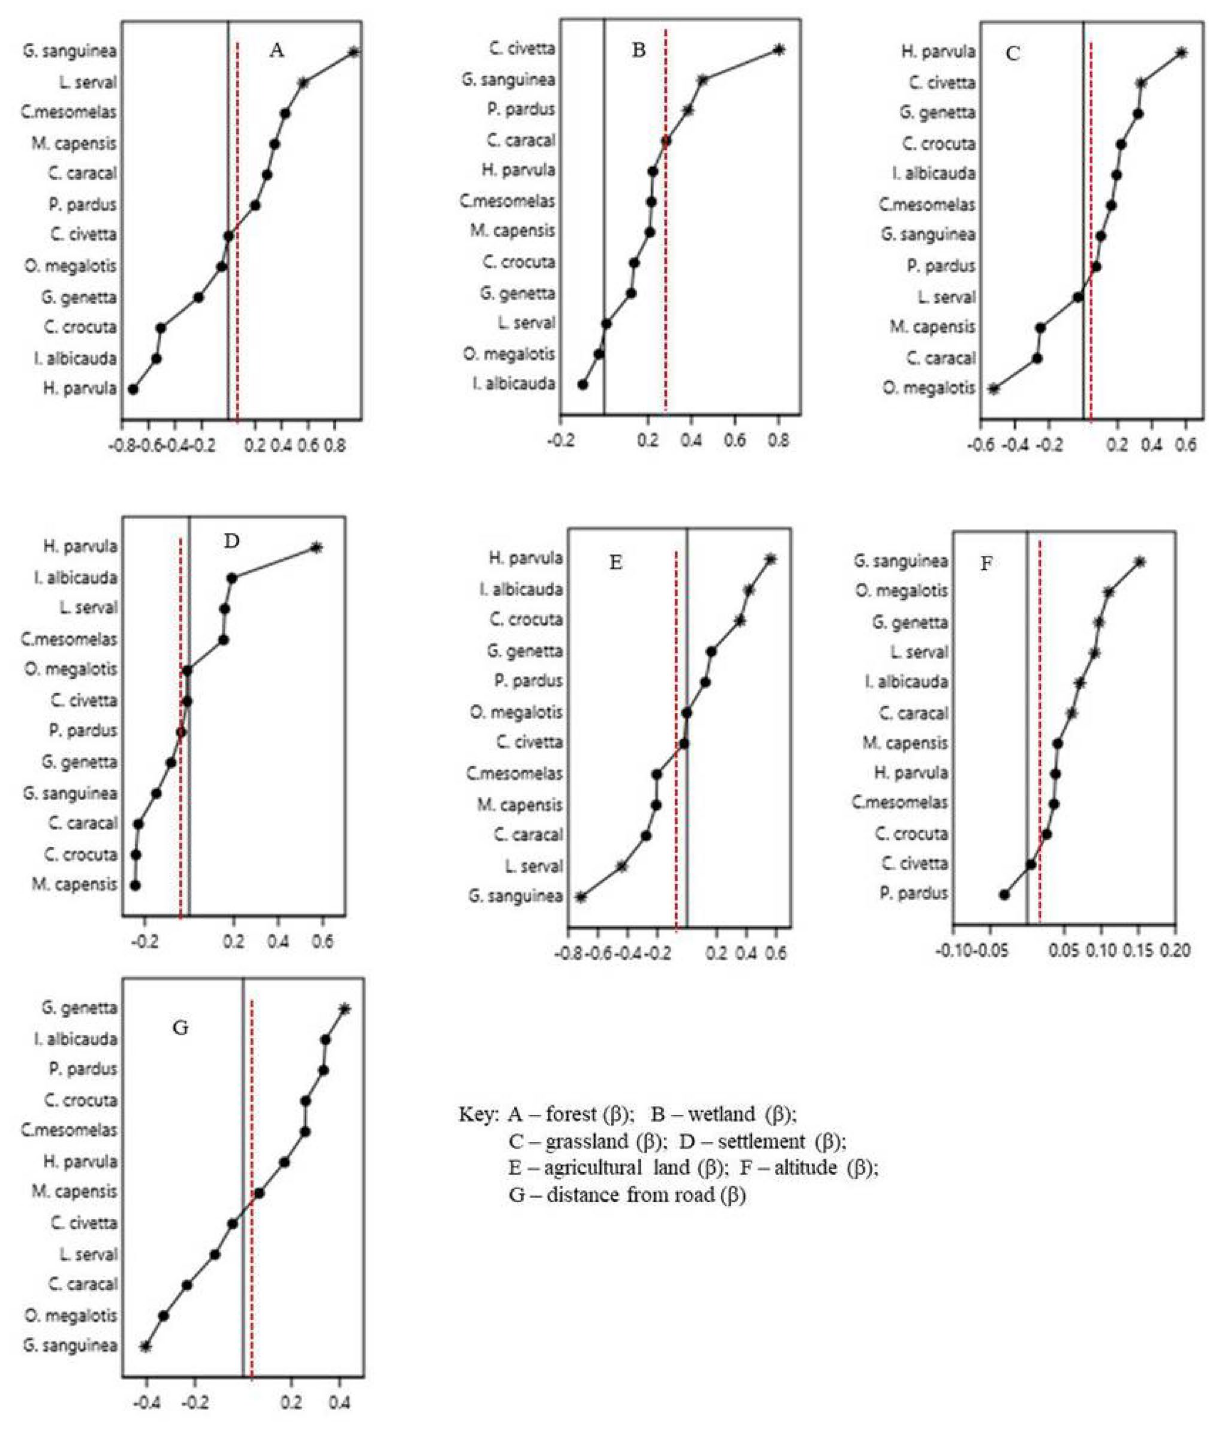
exclude zero), dots indicate coefficient ( β ) values, solid central axis indicates demarcation (zero point) for positive (avoidance) and negative association (preference), red dot line indicates community effect indicates the mean for the species-specific